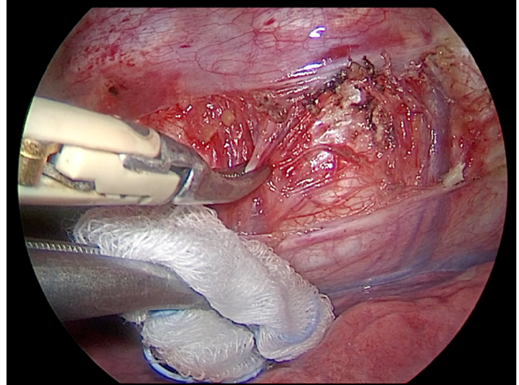
Figure 5. The intercostal vessels are identified and carefully dissected with bipolar forceps. Dissec- tion and coagulation of the vessels below the pleura is helped through the mini-thoracotomy access completing the tethering of the whole spinal curve. The tether is cut proximally and distally, with a pad mounted on Kelly instrument. This maneuver helps to keep the field clean and, in case and a 12-French chest tube for drainage is inserted on the anterior axillary line into one of possible bleeding, to be faster in hemostasis. of the trocar sites, then positioned along the costovertebral sinus, with its tip towards the apex to collect possible spillage of postoperative pleural effusion.